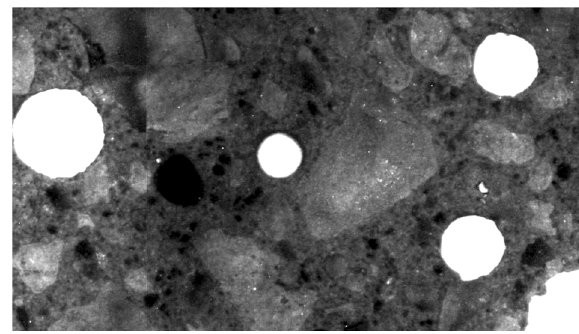
Fig. 11. Porosity characteristics of SCC-M2